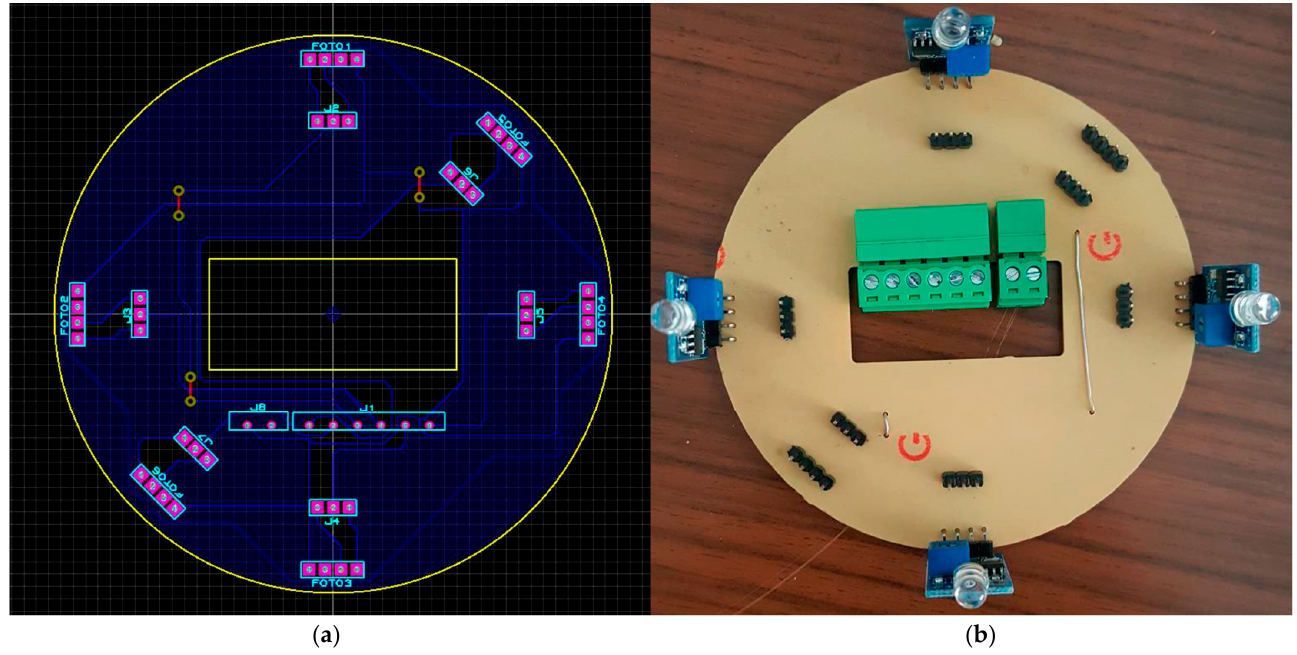
Figure 11. ( a ) Sensor board CAD view. ( b ) Assembled sensor board.